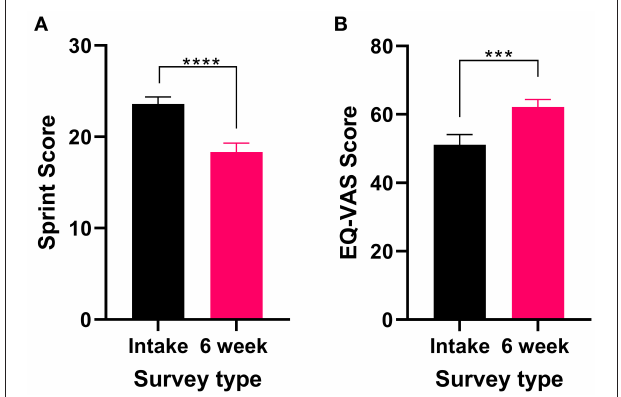
FIGURE 4 | Validated survey scores from the intake survey (baseline) and 6-week follow-up survey for patients reporting PTSD as their primary medical condition. Overall, there was an improvement in patient’s PTSD and QOL after 6 weeks of medical cannabis treatment. (A) SPRINT scores significantly decreased after 6 weeks of medical cannabis treatment (Wilcoxon test P < 0.0001). (B) EQ-VAS score significantly improved from the intake survey to the 6-week follow-up survey ( t 31 = 4.072 P < 0.001), (**** P < 0.0001, *** P <